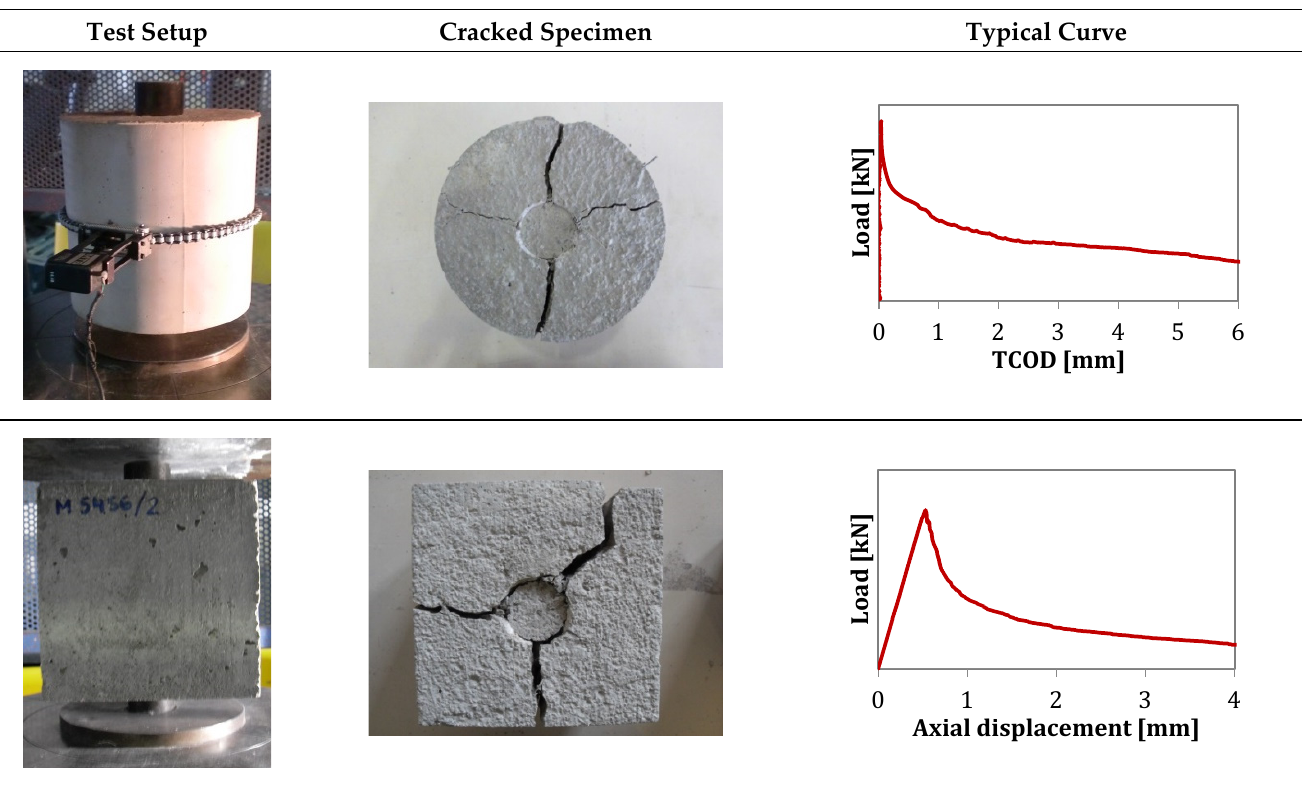
Figure 8 . Barcelona test in cylindrical and cubic specimens. Figure 8. Barcelona test in cylindrical and cubic